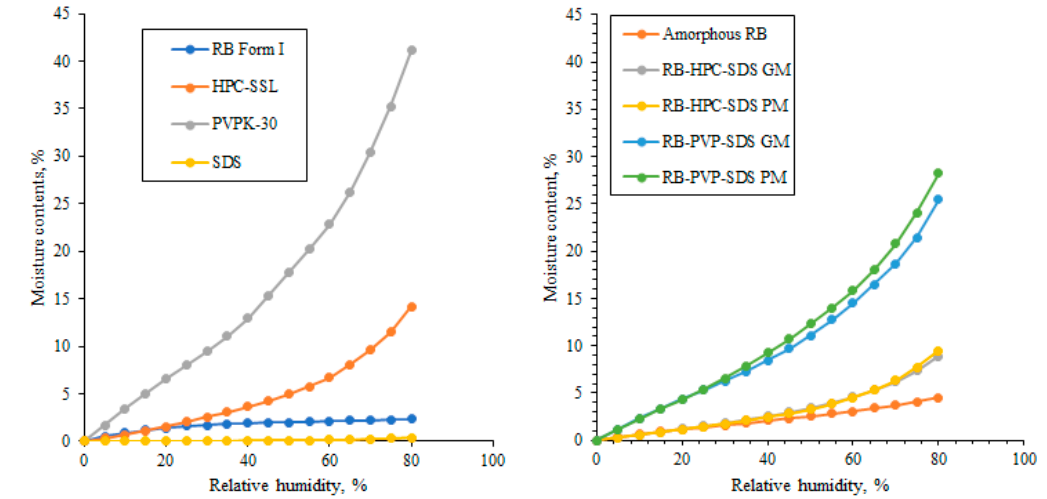
Figure 11. DVS results of bulk materials (left) and prepared samples (right).